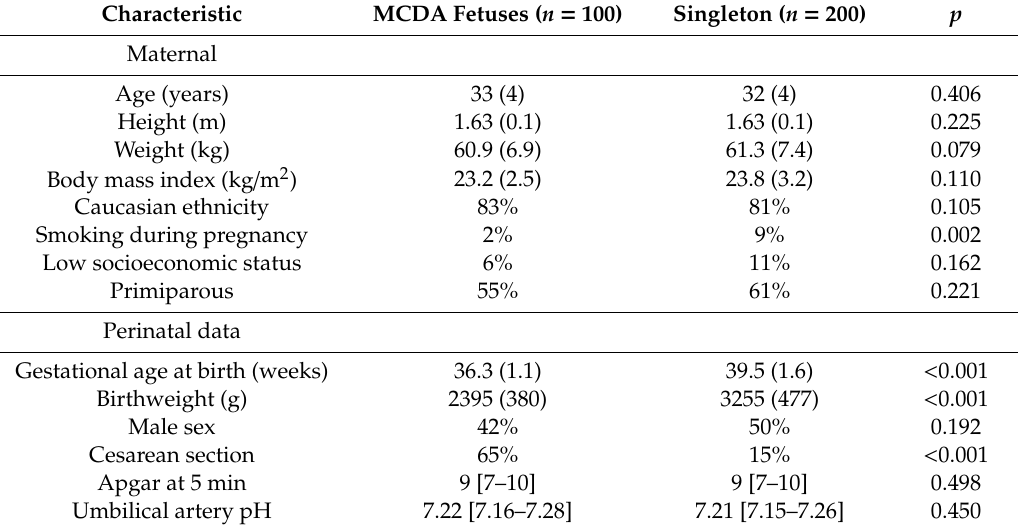
Table 1. Maternal and perinatal characteristics of 100 monochorionic diamniotic twin fetuses and 200 low-risk singletons.